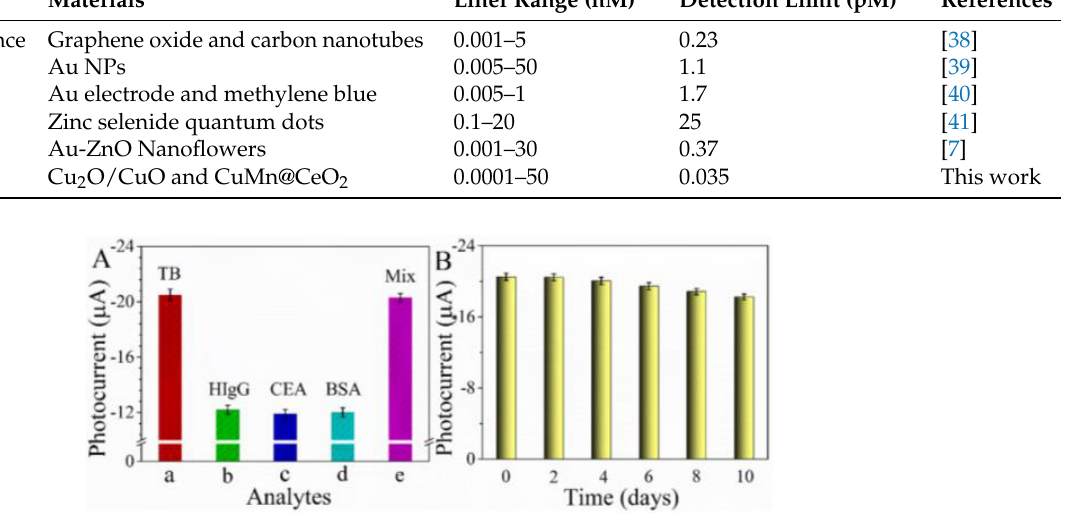
Figure 7. ( A ) Photocurrent of the bioassay in the presence of 0.1 nM sample. ( B ) Photocurrent responses of constructed PEC sensing platform with 0.1 nM TB.